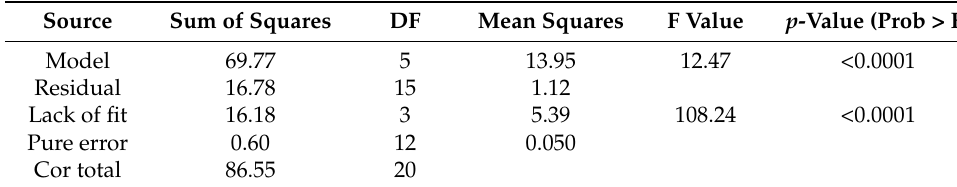
Table 2. ANOVA for response surface quadratic model. Source Sum of Squares